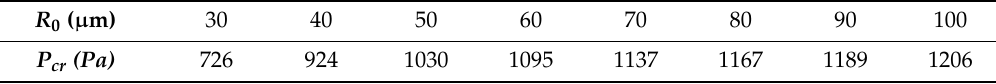
Table 2. Critical pressure for each nuclei